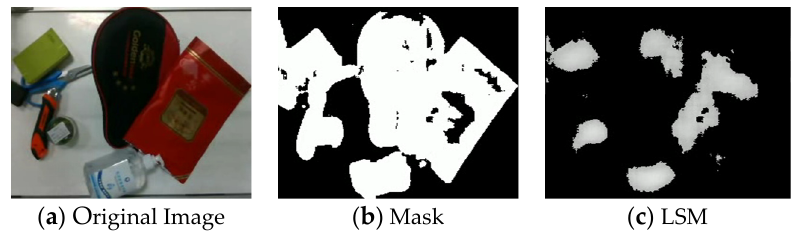
Figure 13. Poor results of LSMNet on the Level 3 video.